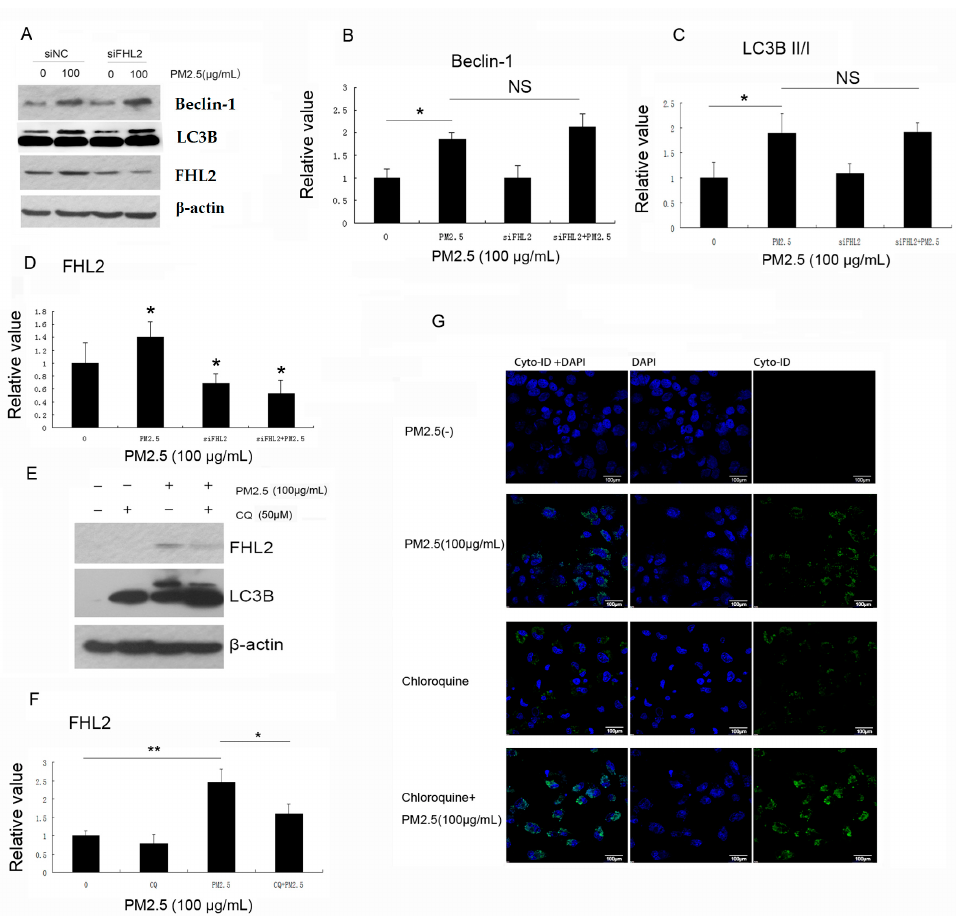
Figure 4. The relationship between autophagy and FHL2 expression. ( A ) MAECs were transfected with siFHL3 or siNC for 48 h and exposed to 100 µg/mL PM2.5 for another 24 h, and protein levels of FHL2 , LC3B, and Beclin-1 were detected in whole-cell lysates ( n = 3); ( B – D , F ) Bands quantifying Western blot results; ( E ) MAECs were pretreated with CQ for 1 h, followed by exposure to PM2.5 (100 µg/mL) and analysis of FHL2 expression 24 h after exposure, ( n = 3). * p < 0.05; ** p < 0.01; ( G ) MAECs were treated with CQ or PM2.5 as described in ( E ), and autophagy was examined by confocal microscopy after staining with Cyto-ID Green. DAPI (4 ′ ,6-diamidino-2-phenylindole) is commonly used for nuclear staining. Scale bar = 100 µm. NS, no significance.